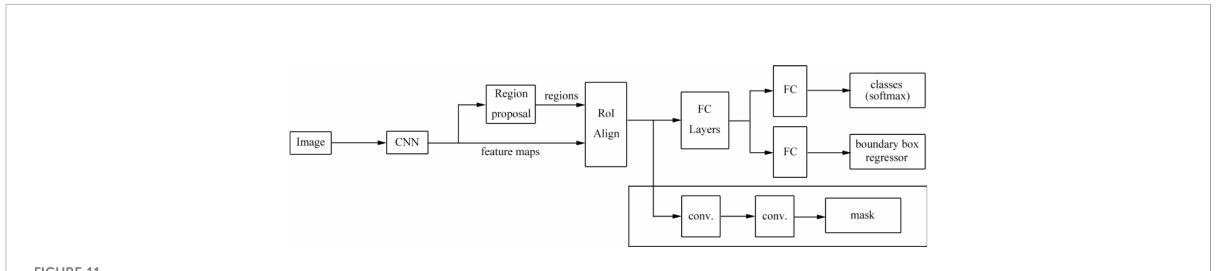
FIGURE 11 The mask R-CNN architecture proposed by Gamage et al. (53). The model is a region proposal network with two outputs (a class label and an object region). Mask R-CNN outputs an object mask, ROI boxes, and a bounding box regressor. This mask supports object segmentation more accurately.